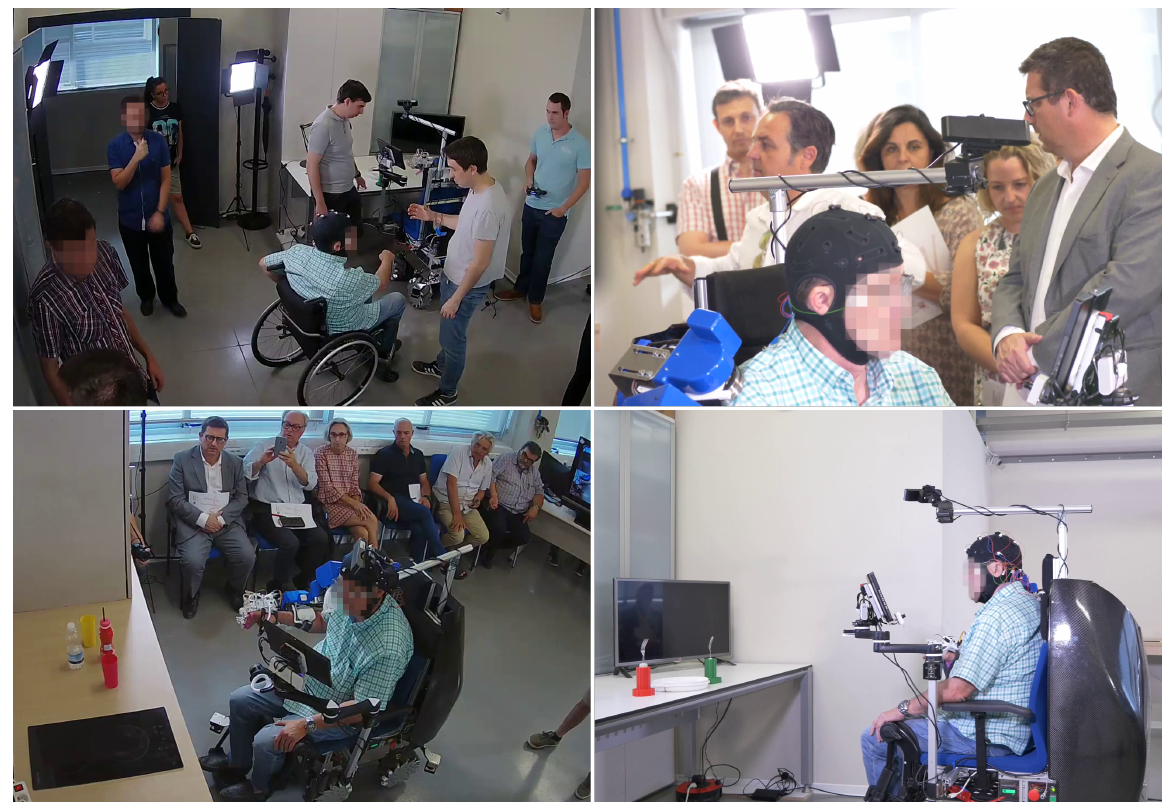
Figure 7. Pictures of the experimental session in the simulated home environment with the subject and the group of